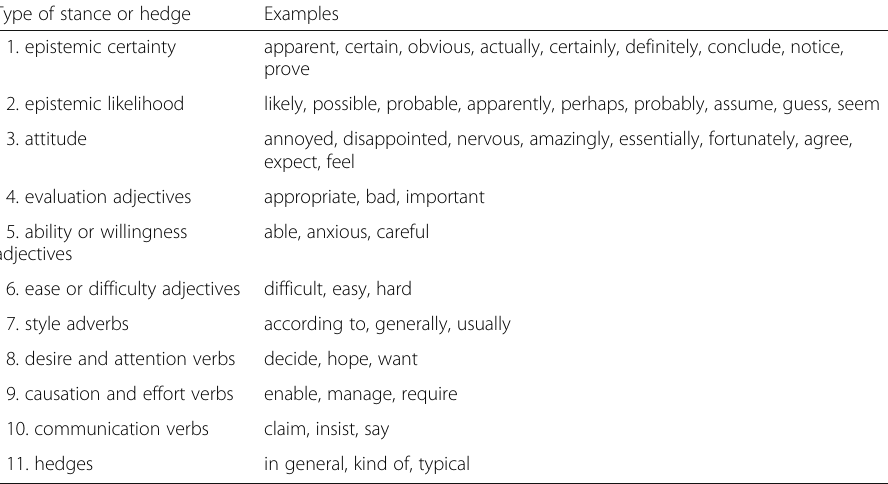
Table 1 Types of stances and hedges evaluated in the